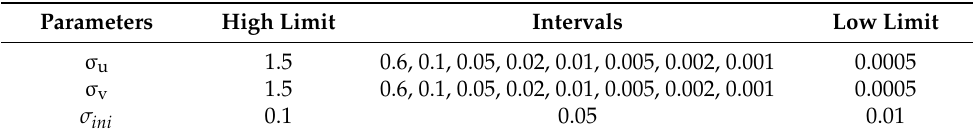
Table 9. Grid Search Optimization